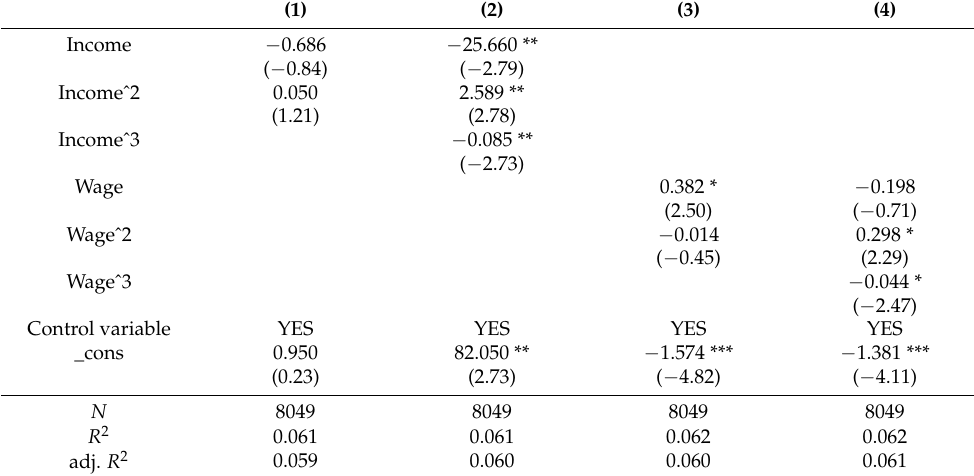
Table 4. Non-linear analysis results.